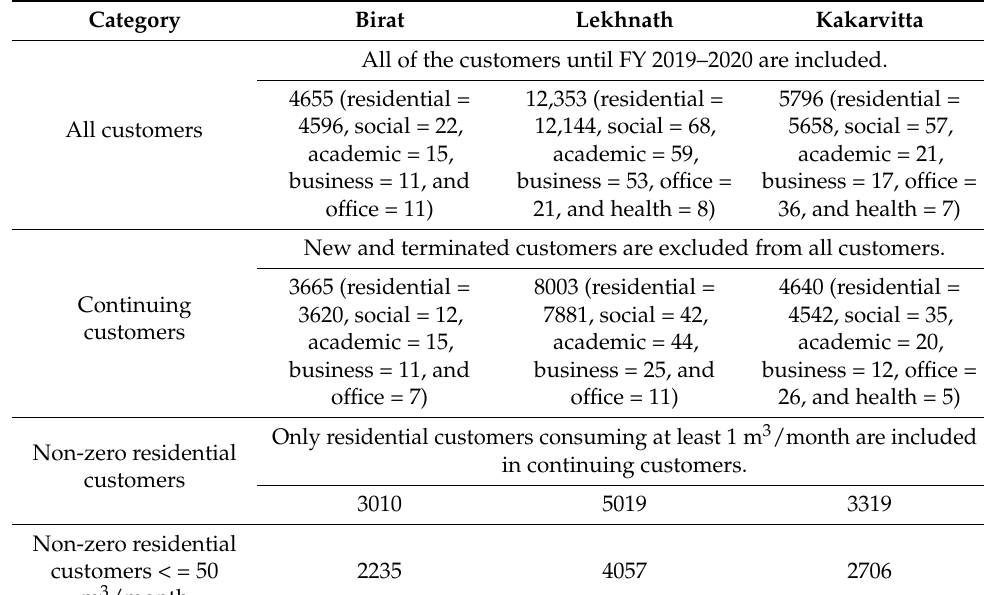
Table A1. Customers’ category